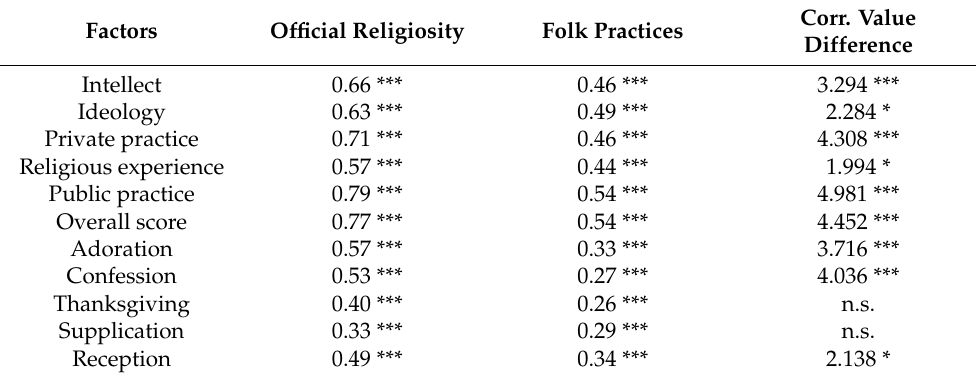
Table 5. Correlation values between official religiosity/folk practices, the CRS, and the MPI (Sample 2). Factors Official Religiosity Folk Practices